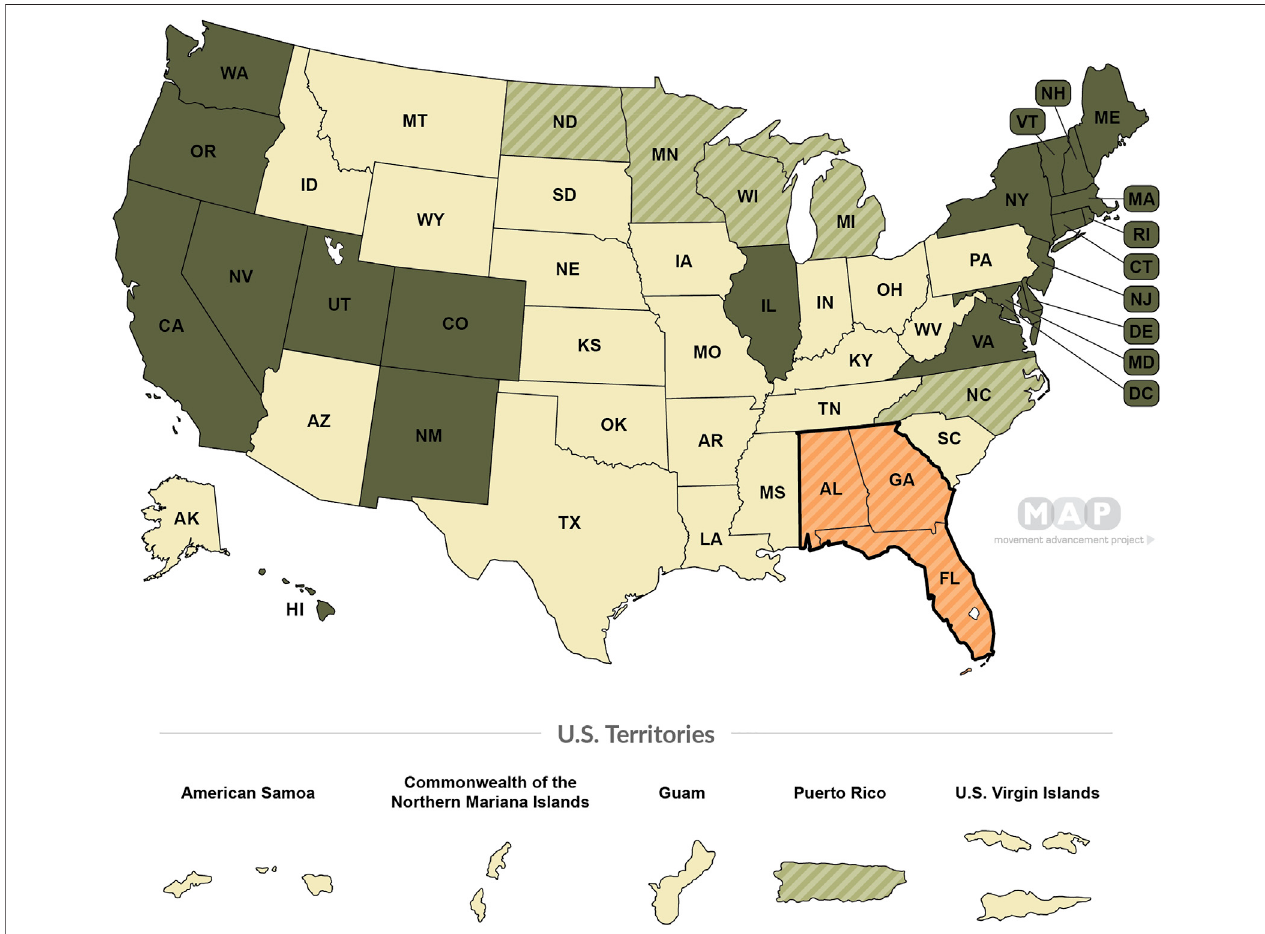
FIGURE1| The fi gure showsthe statesand territories oftheUnited States and theircurrent status oftheirlaw against conversion therapies. DarkGreen: Statelaw bans conversion therapyforminors;GreenStripes: Statepartiallybansconversion therapyforminors;LightGreen:Nostatelaw orpolicy;RedStripes: Stateisinfederal judicial circuit with a preliminary injunction currently preventing enforcement of conversion therapy bans. The map comes from the Movement Advancement Project (MAP),athinktankfoundedin2006tohelppromoteequalityandopportunityforallthroughin-depthresearch,insightandcommunication.Thedatashownhereis from April 10, 2021 (Movement Advancement Project,